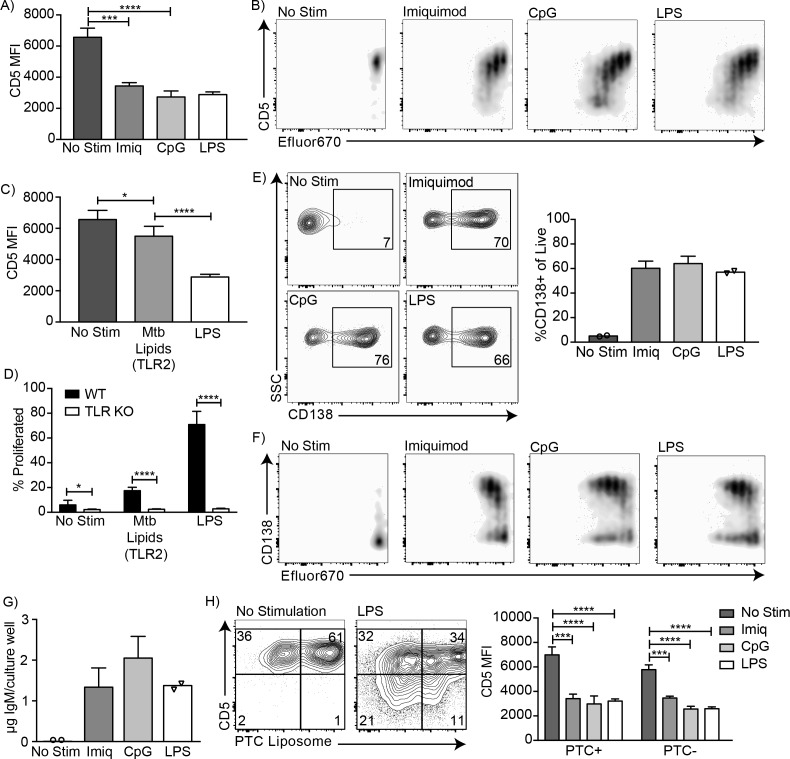
CD5+ B-1 cells differentiate into CD5- IgM secreting cells after TLR-mediated activation.(A) CD5 MFI ± SD and (B) representative FACS plots for CD5+ B-1 cells cultured without stimulation or with Imiquimod (TLR7 agonist), CpG 7909 (TLR9 agonist), or LPS (TLR4 agonist) (n = 3–5). (C) Mean CD5 MFI ± SD of CD5+ B-1 cells cultured without stimulation or with Mycobacterium tuberculosis (Mtb) lipids (TLR2 agonist) or LPS (n = 4–5). (D) Mean percentage ± SD of B-1 cells from wild type (WT) or Tlr2−/−xTlr4−/−xUnc93b13d/3d (TLR KO) mice that underwent at least one division after culture without stimulation or stimulated with Mycobacterium tuberculosis (Mtb) lipids or LPS (n = 6–9 per group). (E) FACS plots (left) and mean percentage ± SD (right) of CD138+ cells, and (F) representative FACS plots for CD138 expression among proliferating cells. (G) Mean IgM concentration ± SD (µg total per culture well) of cultured CD5+ B-1 cells stimulated or not with Imiquimod (TLR7 agonist), CpG 7909 (TLR9 agonist), or LPS (TLR4 agonist) (n = 2 for no stimulation and LPS, n = 5 for Imiquimod and ODN). (H) Sample FACS plot (left) and mean CD5 MFI ± SD (right) of PTC liposome-binding (PTC+) and non-PTC liposome-binding (PTC-) cells for CD5+ B-1 cells cultured without stimulation or with Imiquimod (TLR7 agonist), CpG 7909 (TLR9 agonist), or LPS (TLR4 agonist) (n = 3–5). Results are combined from two (D, E–G), or are representative of three (A) or two (B, C, H) independent experiments, respectively. Values compared in (A, C–D) using an unpaired Student’s t test (*=p < 0.05, **=p < 0.005, ***=p < 0.0005, ****=p < 0.00005).